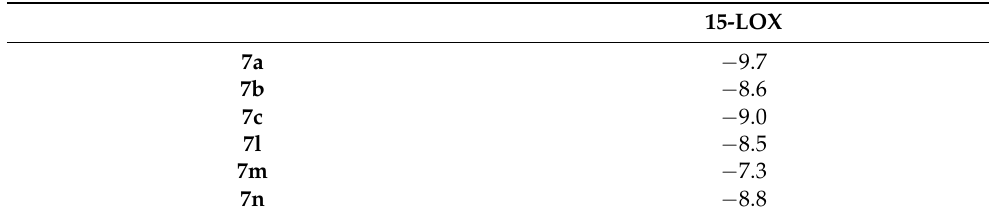
Table 2. Binding affinity (kcal/mol) for interaction compounds 7a – 7c and 7l – 7m with 15-lipoxygenase